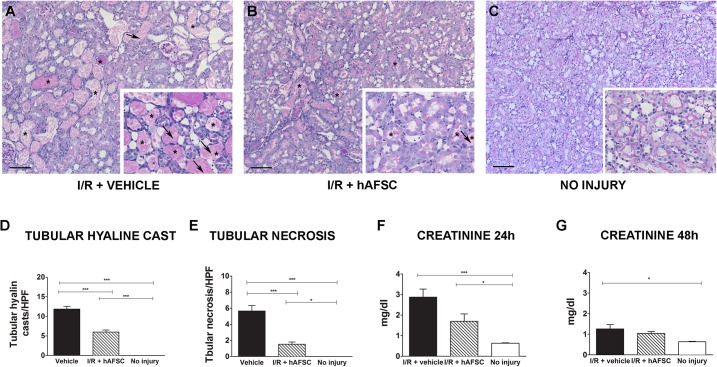
Protective effect of stem cell therapy on acute kidney ischemia reperfusion injury.PAS staining of representative kidney sections from different experimental groups. (A) The epithelial injury was characterized by tubular necrosis (shown by arrows), intratubular hyaline casts (shown by asterisk *), denudation of basal membrane and vacuolization of tubular epithelial cells with a loss of their brush border. (B) The renal tissue showed less severe injury, with less hyaline casts and tubular necrosis in the group treated with stem cells (arrow indicates presence of brush borders). (C) Histology of a kidney without injury (D). Quantitative analysis of the presence of tubular hyaline casts, (E) tubular necrosis (F-G) and serum creatinine levels (mg/dl) at 24h and at 48h of the three cohorts (vehicle treated (black), hAFSC treated (striped) and no injury (white)). * p<0.05, ** p<0.01 *** p<0.001. (scale bar = 50 μm)